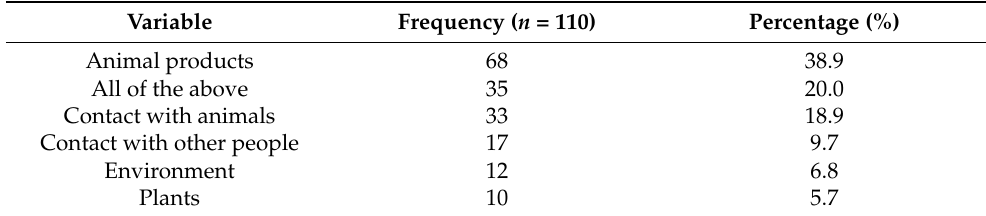
Table 4. The veterinarians’ opinion on potential exposure routes of humans to resistant bacteria.